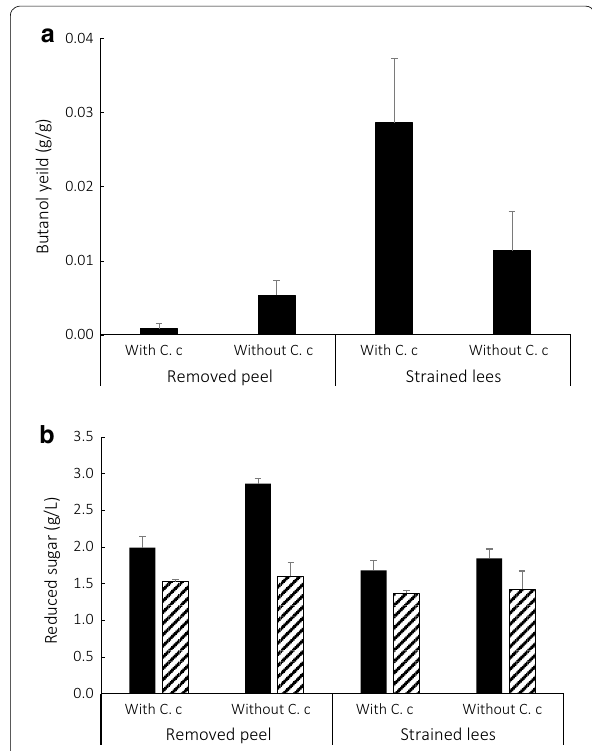
Fig. 6 a Butanol yield in the culture supernatants with C. beijerinckii from removed peel and strained lees with or without C. cellulovorans . Values are mean SE of four independent samples. b Concentration ± of reducing sugar in the culture supernatant from removed peel and strained lees with or without C. cellulovorans . Closed and hatched bars indicate before addition of C. beijerinckii and after addition of